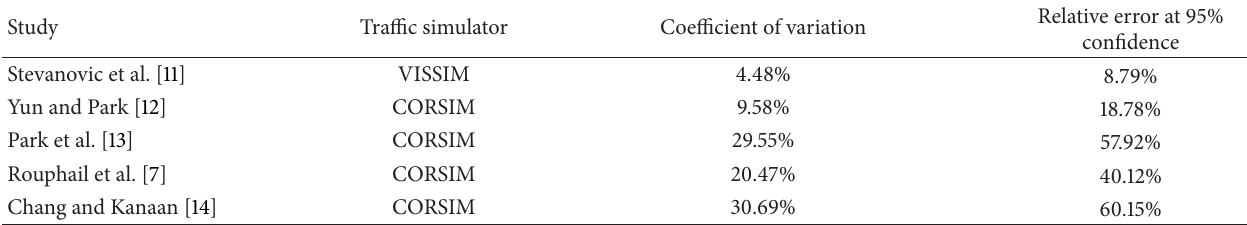
Table 1: Maximum estimated coefficient of variation for network average